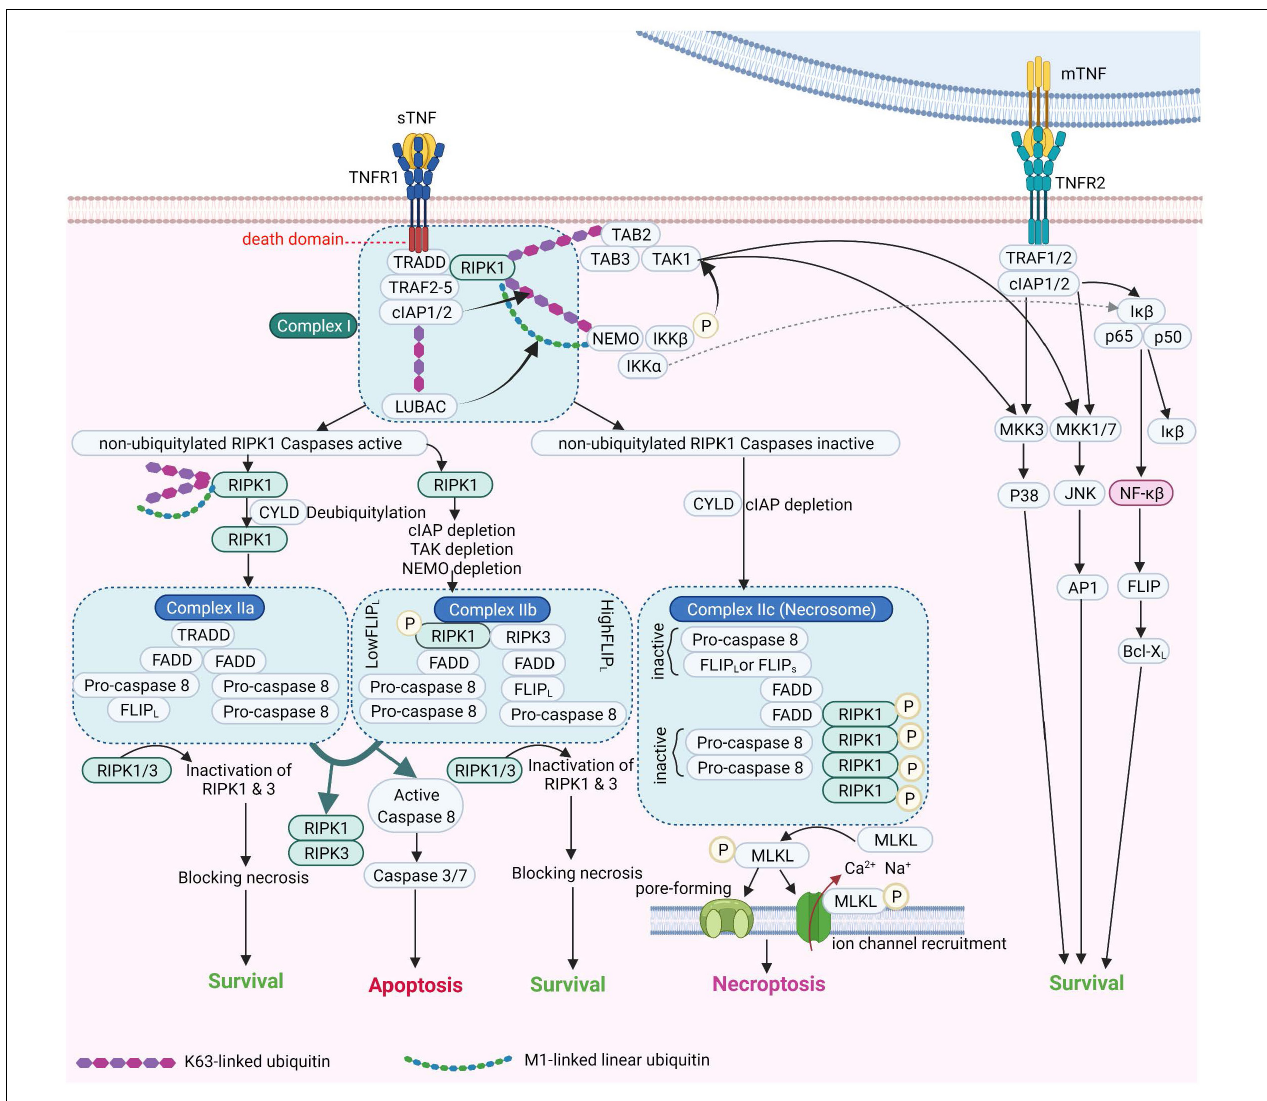
FIGURE 2 | TNF Receptor-1 and TNF Receptor-2 signaling pathways [Adapted from Brenner et al. (2015) and Conrad et al. (2016)]. cIAP, Cellular Inhibitor of Apoptosis Protein; FADD, Fas-associated protein with death domain; FLIP L , FLICE-like inhibitory protein; IKK, I κ B kinase; JNK, c-Jun NH2-terminal kinase; LUBAC, linear ubiquitin chain assembly complex; MLKL, mixed lineage kinase domain-like; mTNF, membrane TNF; NEMO, NF- κ B essential modulator; NF- κ B, Nuclear factor kappa B; NIK, NF- κ B-inducing kinase; RIPK1, Receptor-interacting serine/threonine-protein kinase 1; sTNF, soluble TNF; TAK1, transforming growth factor-